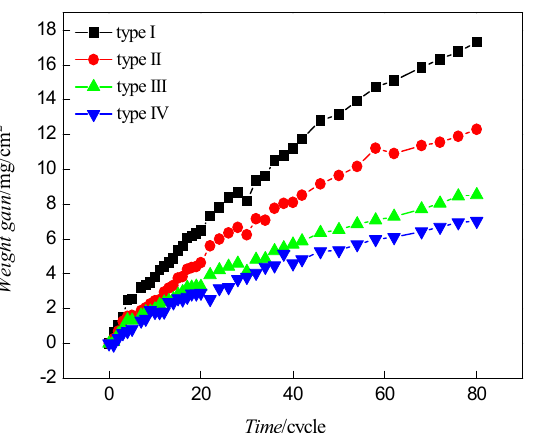
Figure 3. Relationship between weight gains and corrosion exposure time for samples with different oxide scales.